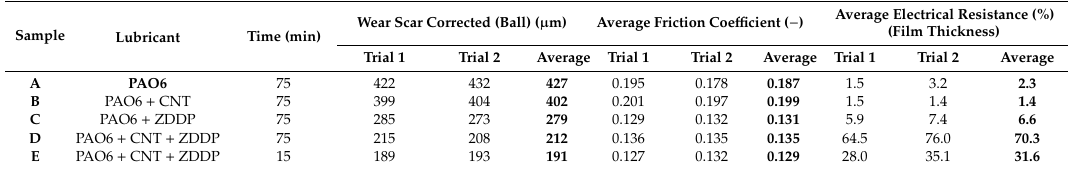
Table 3. Summary of the HFRR